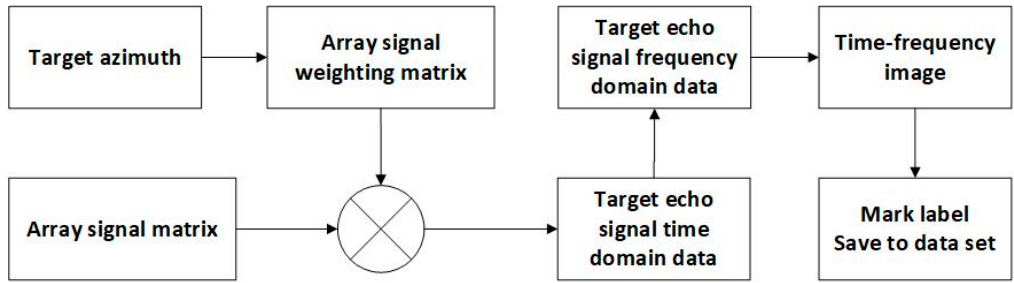
Figure 2. Data set generation process. Generate a weighting matrix according to the target azimuth and multiply it with the array signal to obtain the frequency domain matrix of the target echo signal, then convert it into a time domain matrix, generate a time-frequency image by short-time Fourier transform, and finally label the tag and store it in the data